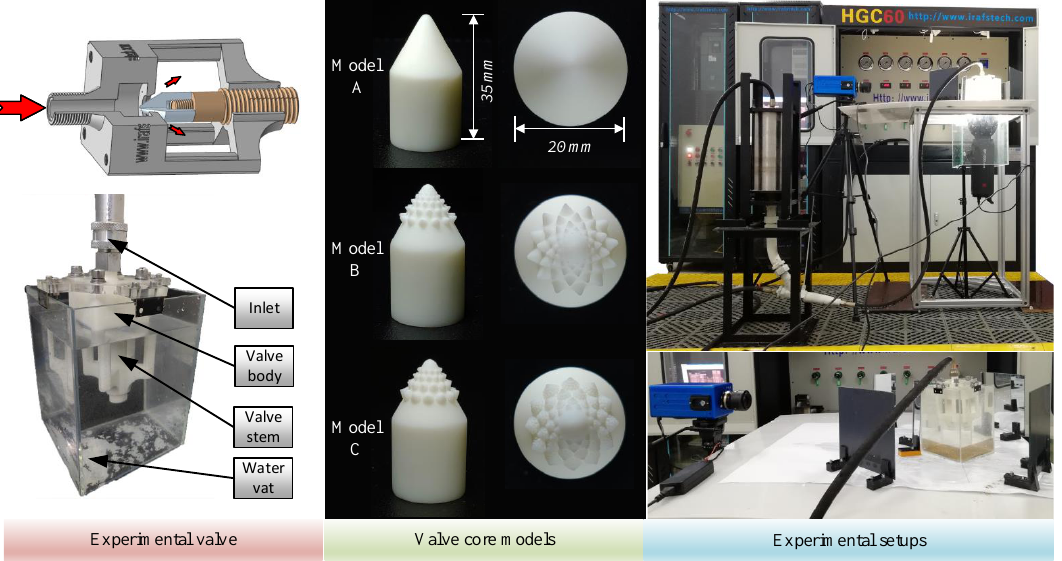
Figure 12. Hydraulic valve and its experimental setups.